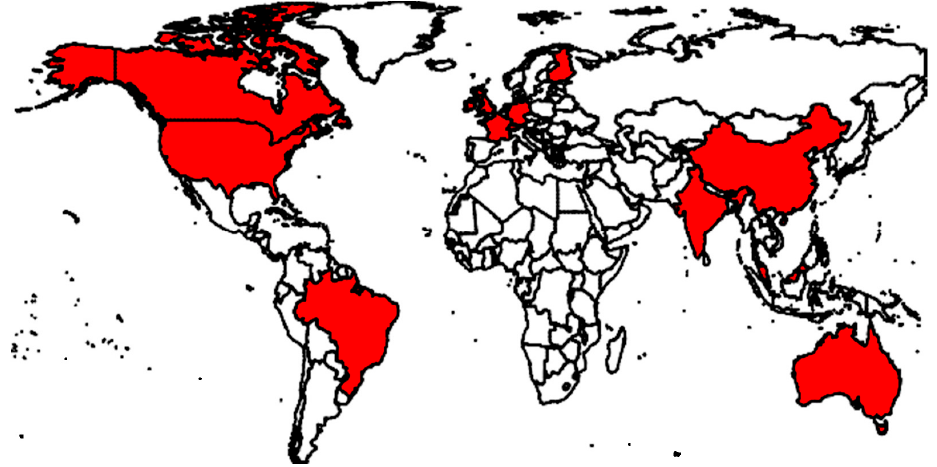
Figure 2. Map of the world with the red regions representing countries where the real-time fluorescent particle instrumentation (UV-APS, WIBS and BioScout) reviewed have been deployed.